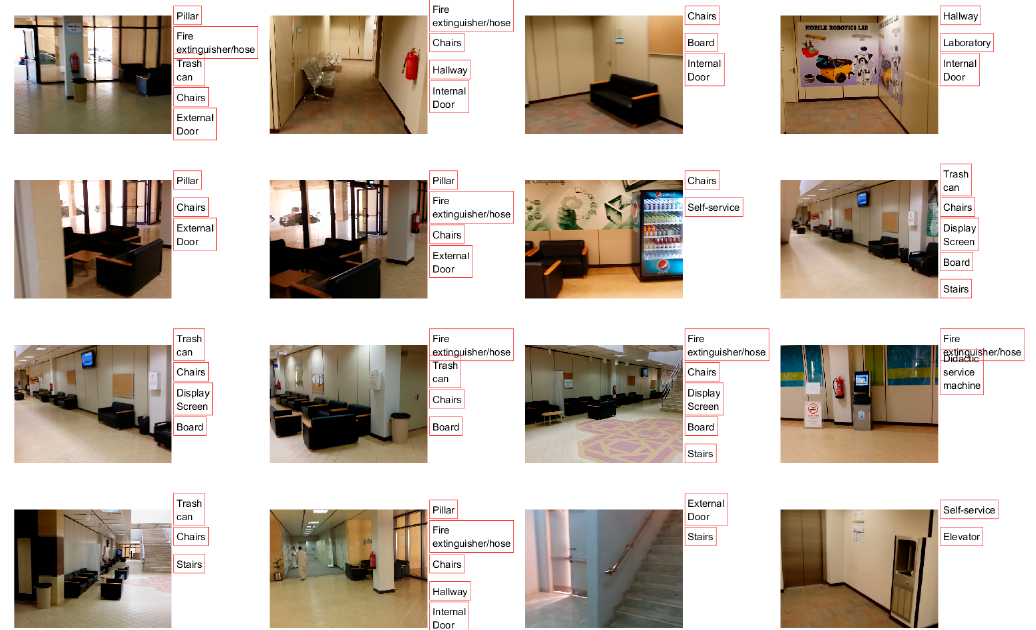
Figure 8. Sample images from the King Saud University 2 dataset (KSU2) and the corresponding labels (objects).